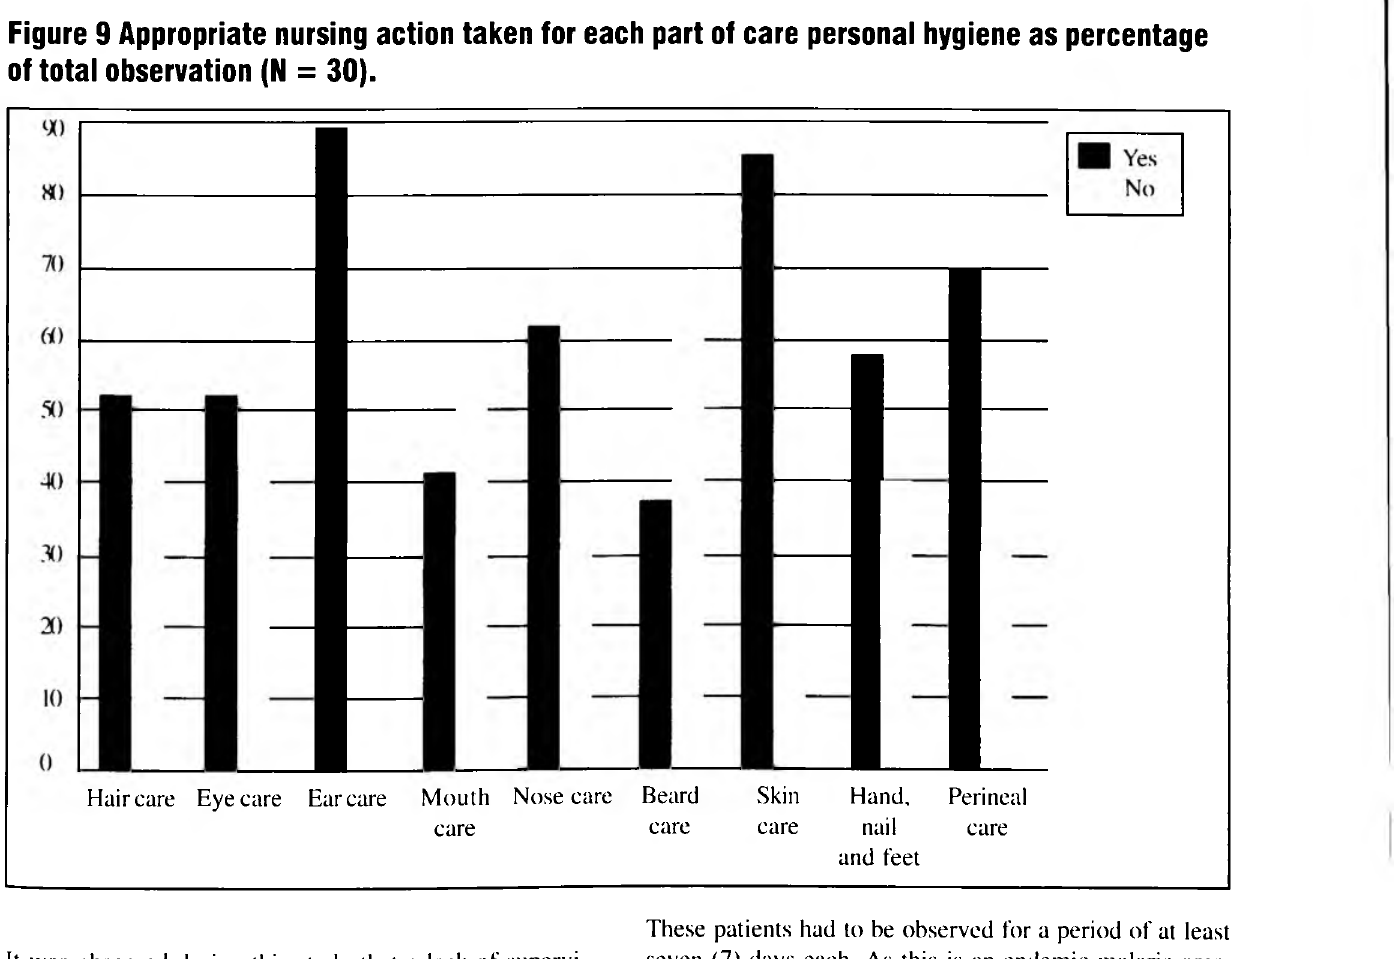
Figure 9 Appropriate nursing action taken for each part of care personal hygiene as percentage of total observation (N =